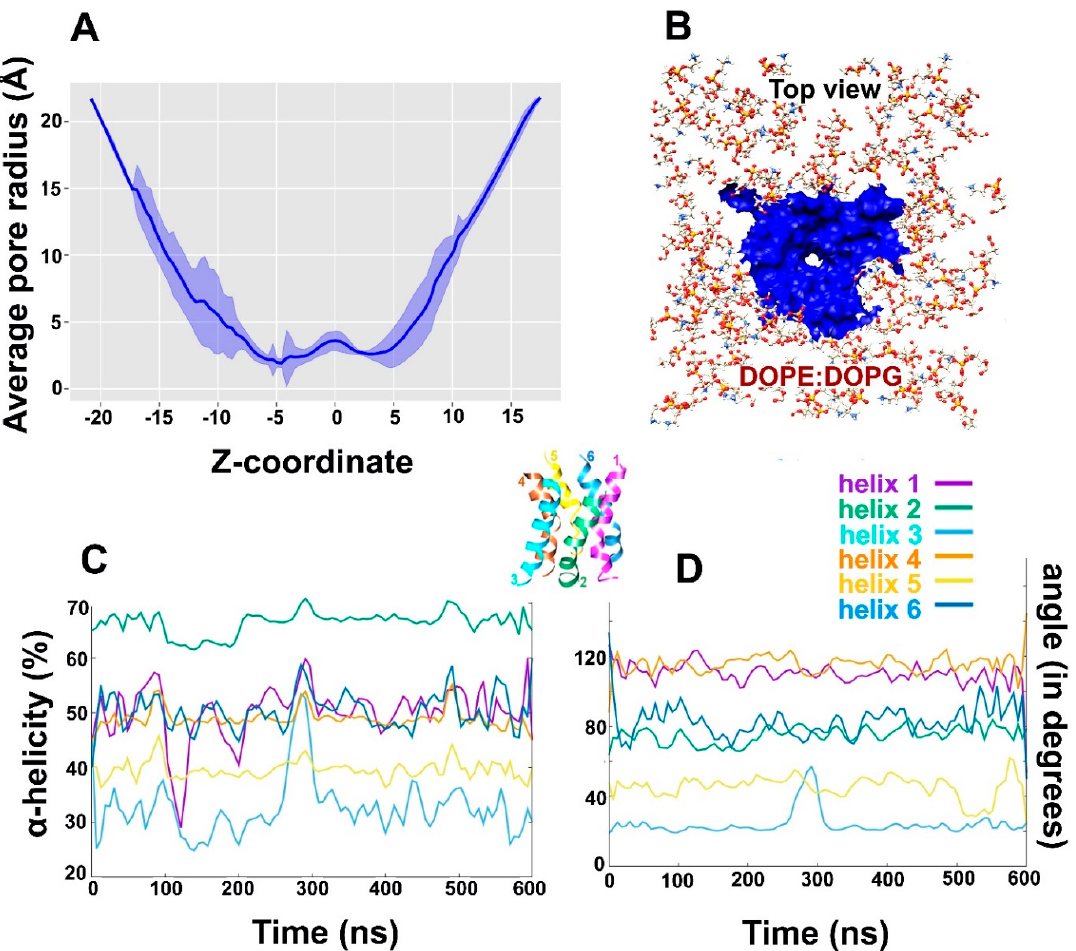
Figure 7. ( A ) The average radius of the Alm F30/3 pore (Å) calculated along transmembrane coordinate. The major fluctuation in the radius is shown by the C-terminus probably to accommodate incoming water flux, ( B ) Cartoon representation of the top view of the Alm F30/3 pore surface in blue, ( C ) percent α -helicity calculated for each Alm F30/3 monomer from the pore with respect to simulation time (in ns), ( D ) the bend angle (calculated as dot product of two